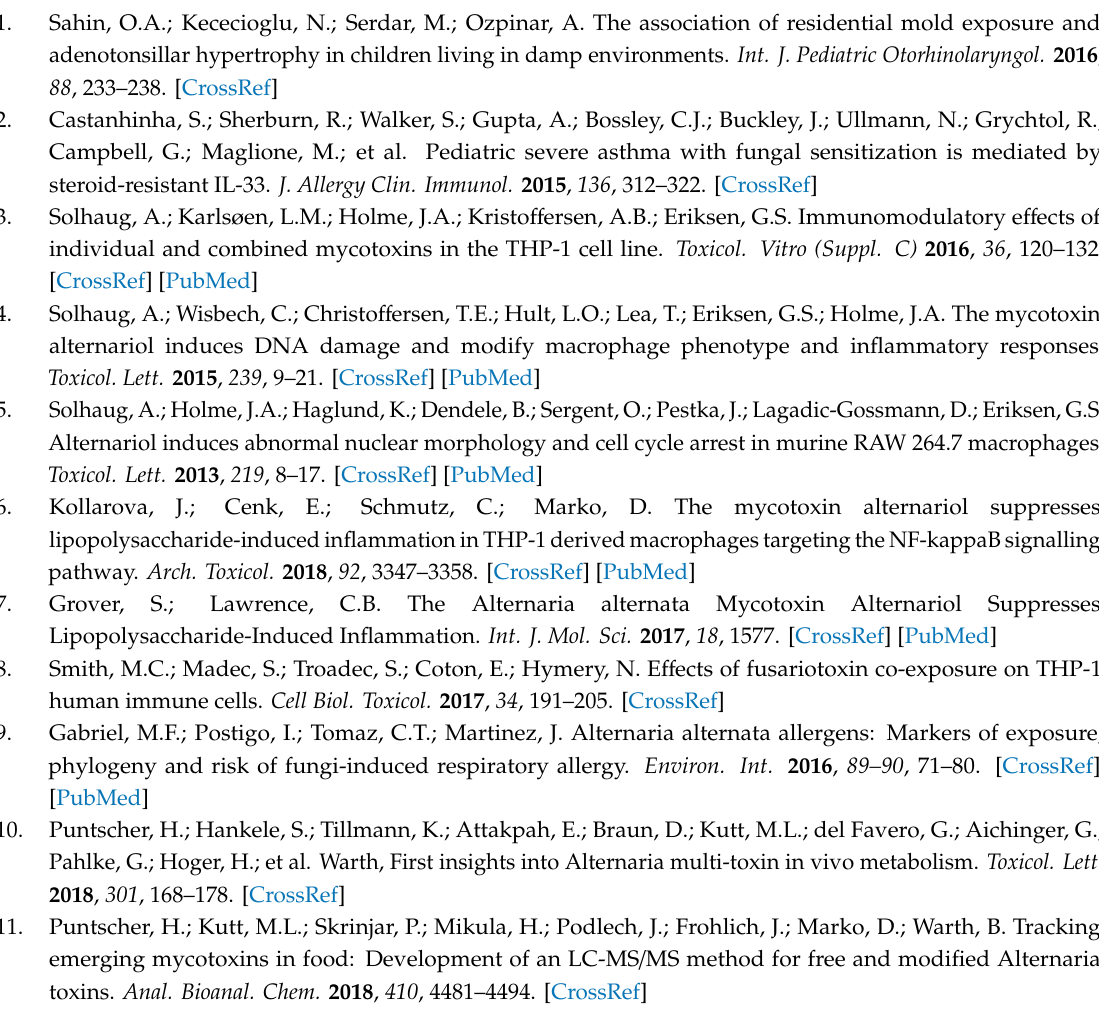
Figure S1: Principal Component Analysis (PCA) of the secretome analysis Figure S2: Evaluation of the cytotoxic potential of the incubation with AOH; Figure S3: Geometrical changes of the CRAC portion of caveolin 1’s CSD domain and AOH; Figure S4: sters identified by the cluster analysis; Figure S5: Representative images of the immunolocalization of Caveolin-1, macrophage migration inhibitory factor, toll like receptor 4 in THP-1 macrophages; Figure S6: Representative images of the immunolocalization of Caveolin-1, macrophage migration inhibitory factor, toll like receptor 4 in THP-1 macrophages; Figure S7: E ff ect of 1 h incubation with 1 µ M AOH and / or 50 µ M M β CD on the pro-inflammatory cytokine